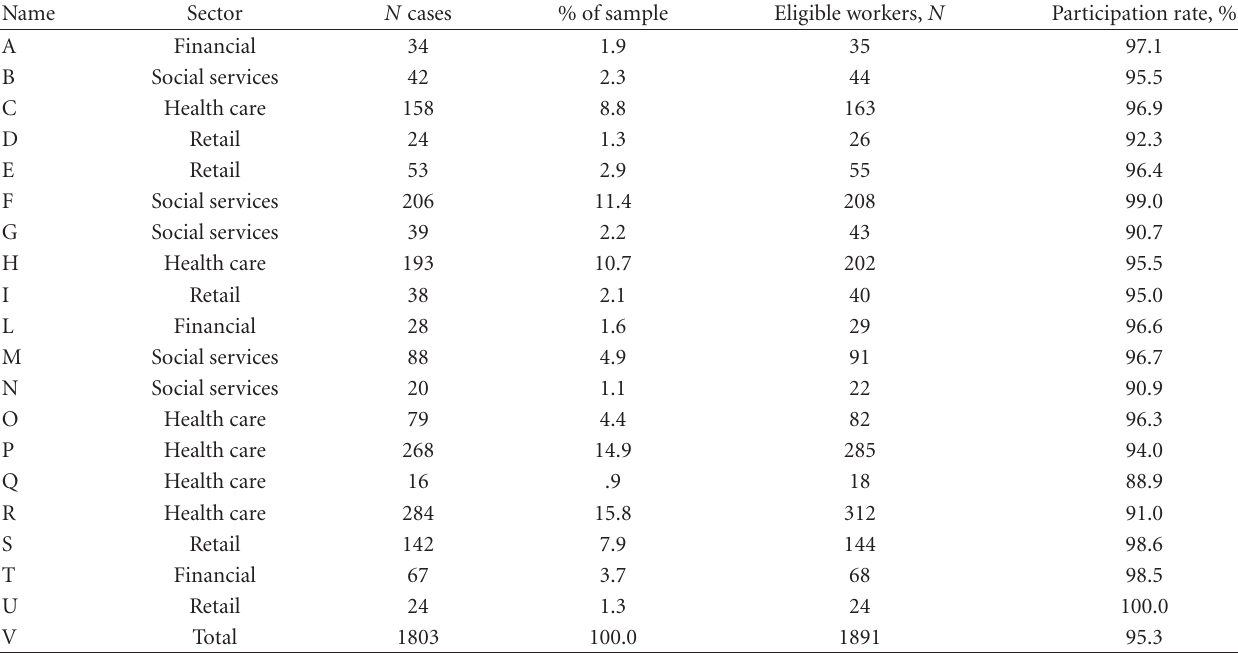
Table 1: Companies participating in the study and participation